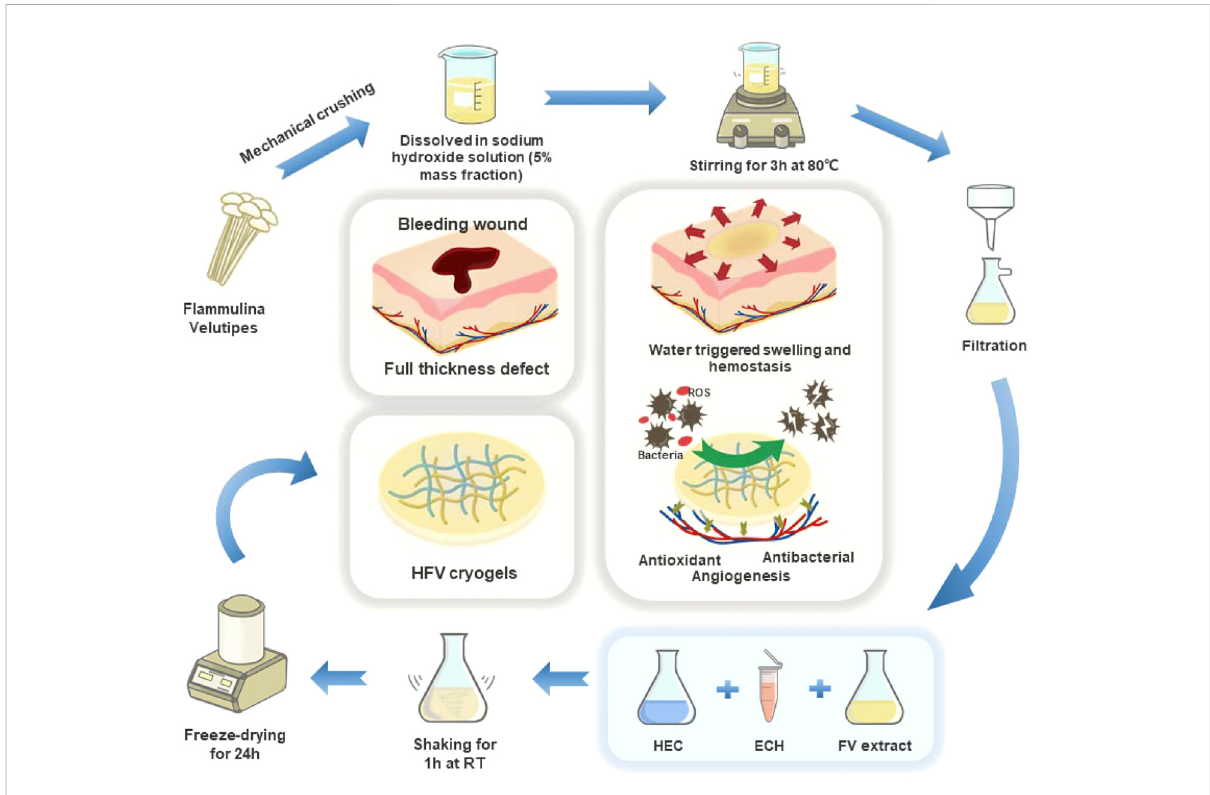
FIGURE 1 Preparation process and biological function of